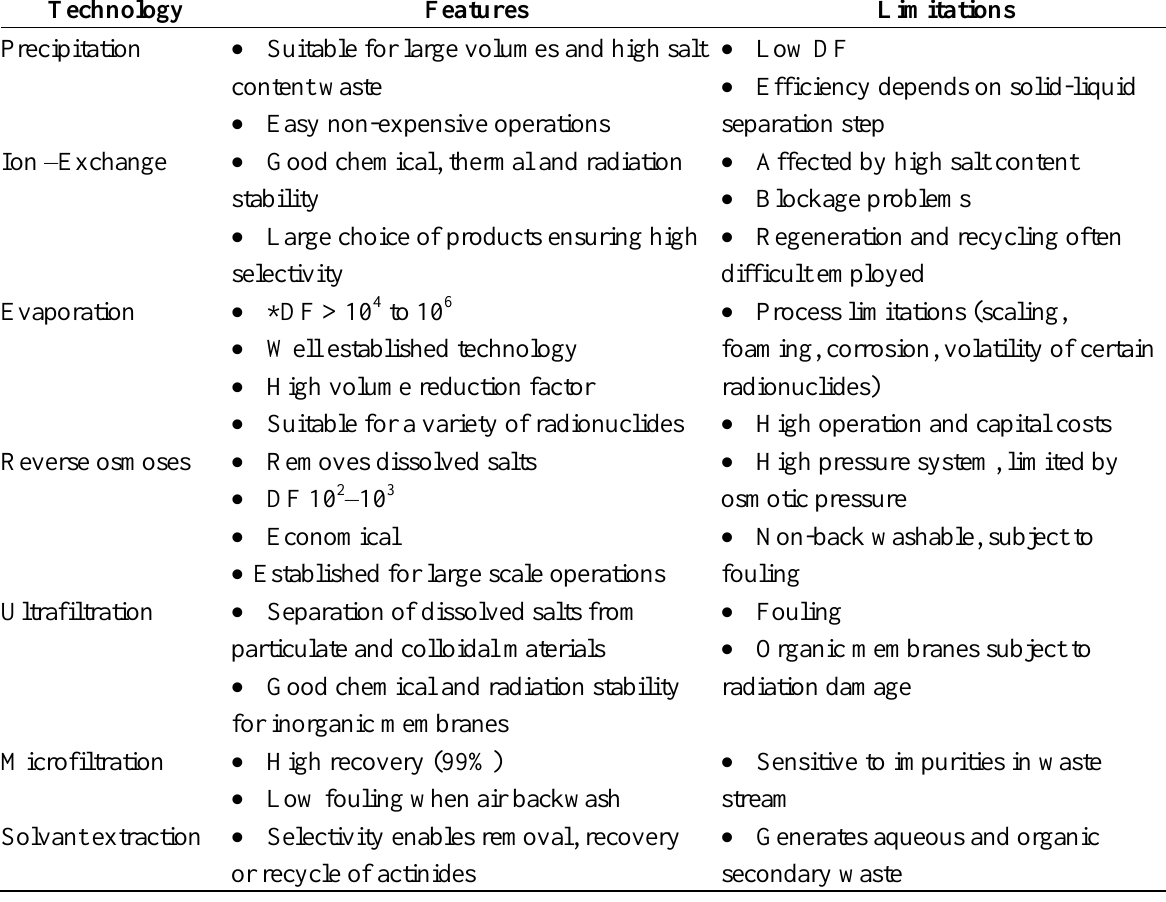
Table 3. Features and limitation of different aqueous liquid treatment options